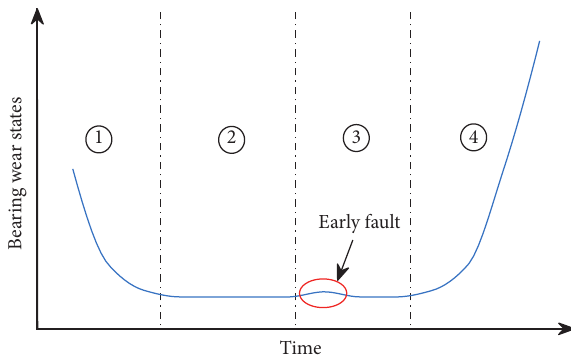
Figure 1: Typical life curve of rolling